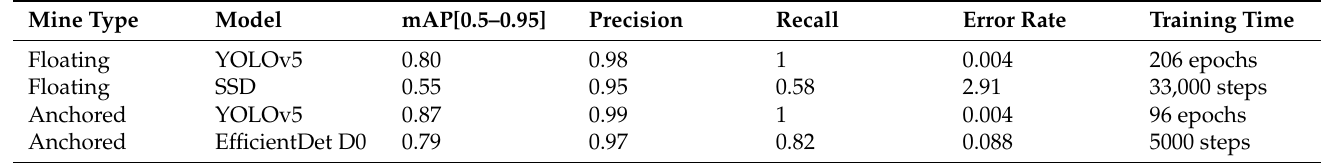
Table 2. Comparison of deep learning algorithms for mine